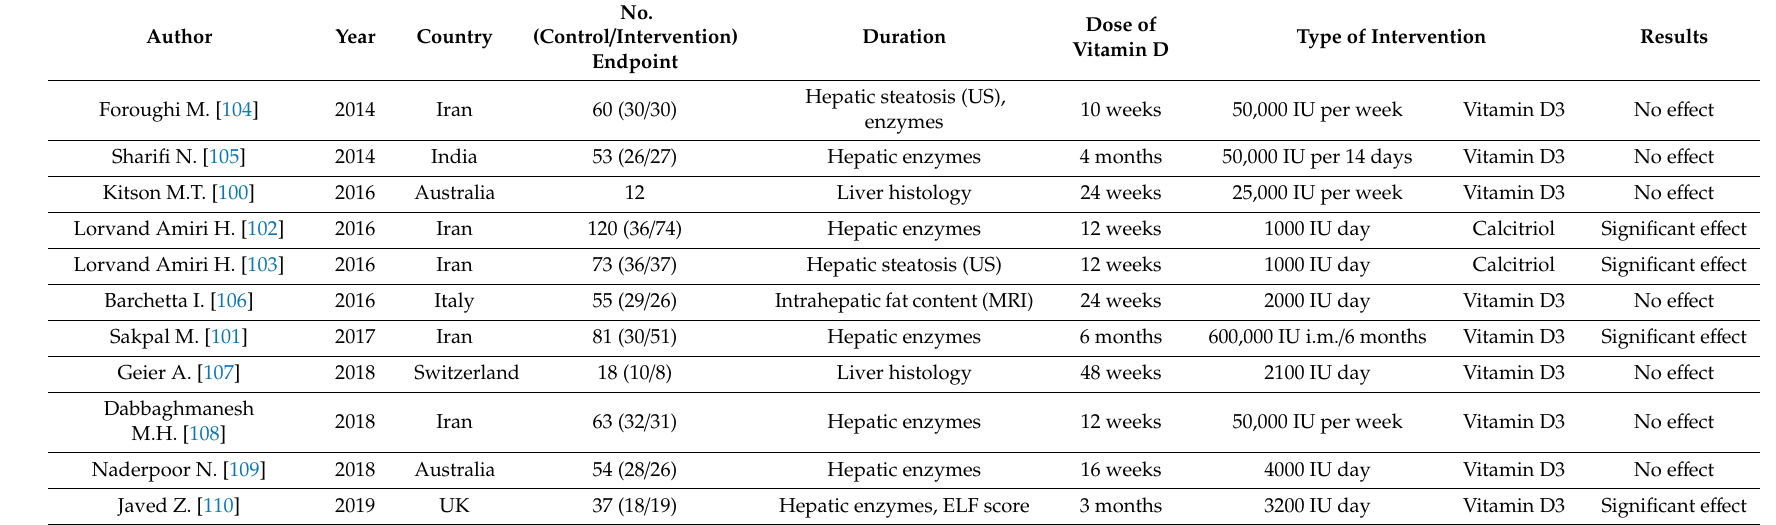
Table 1. Characteristics of clinical trials evaluating vitamin D supplementation on MAFLD. Abbreviations: US—Ultrasound, MRI—Magnetic Resonance Imaging, ELF—Enhanced Liver Fibrosis score, IU—International